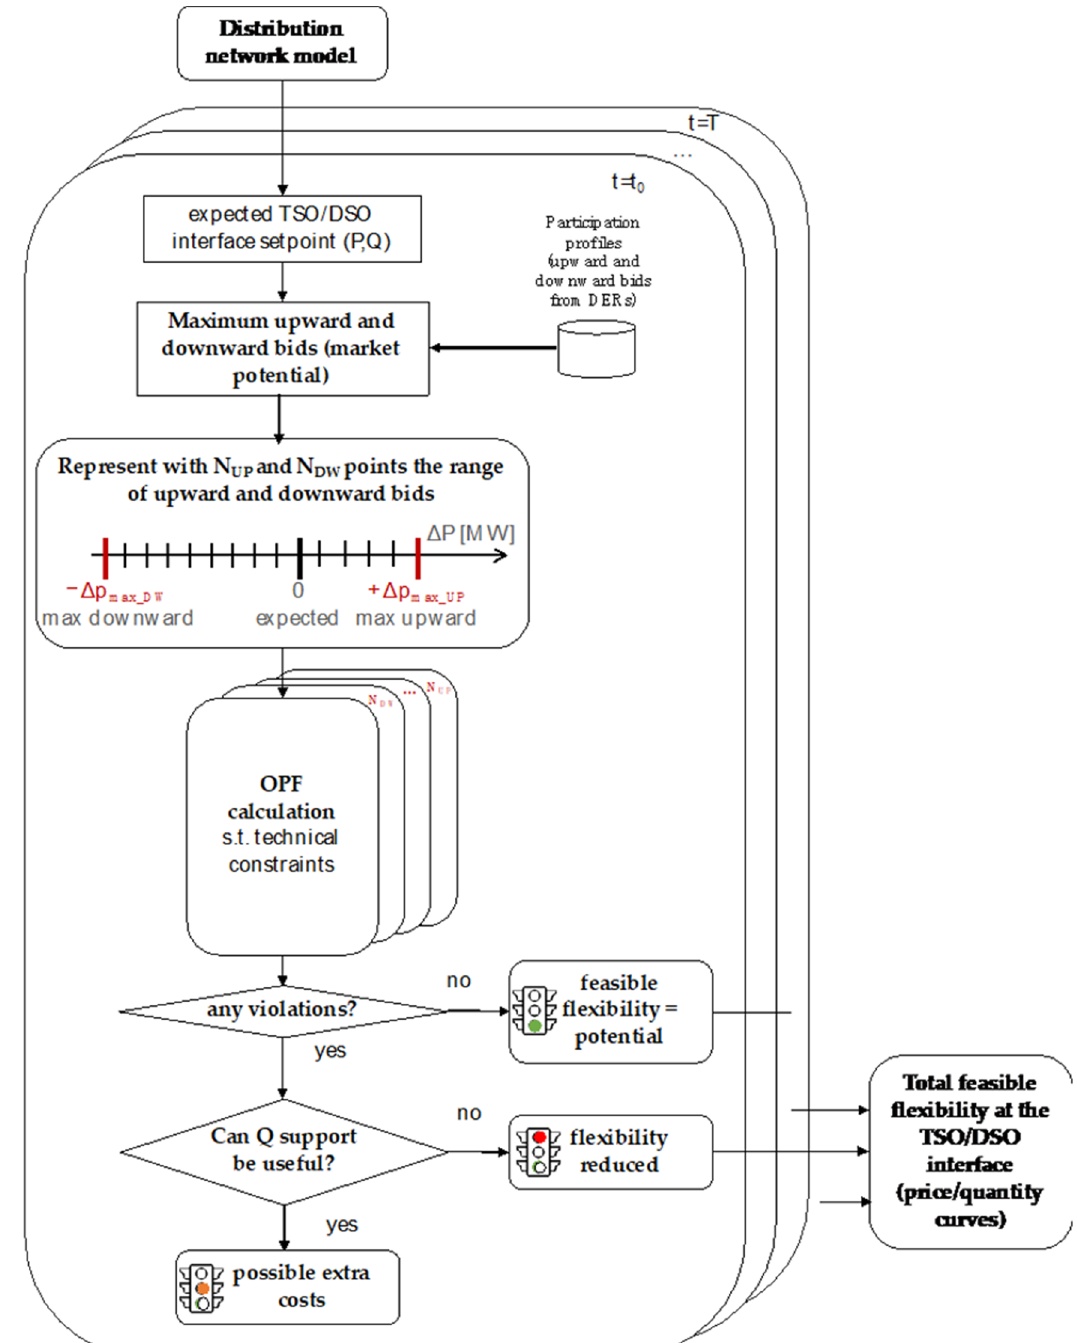
Figure 1. Flowchart of the quantitative assessment of the distribution system flexibility.